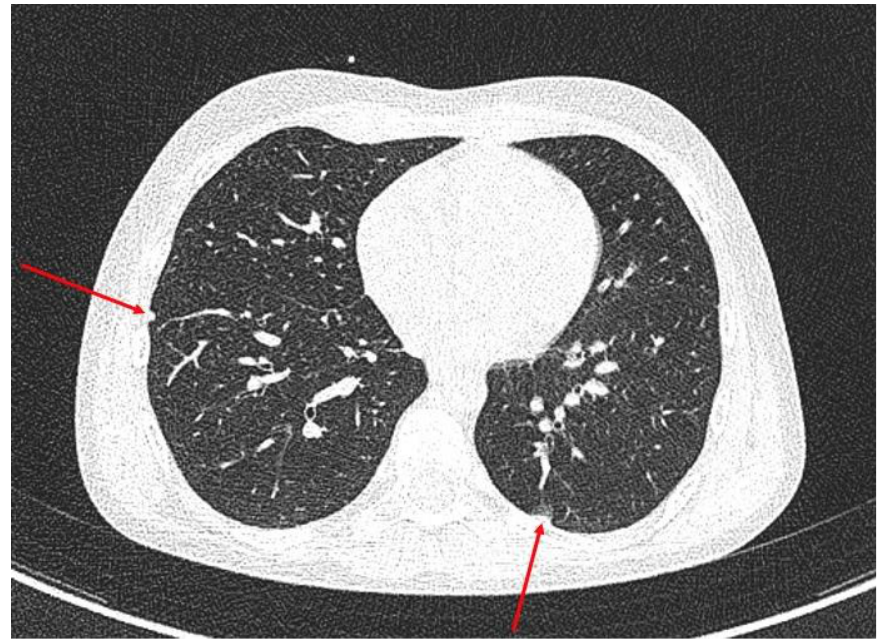
Figure 2. The CT of the chest with nodules within the right and left lungs (marked with an arrows).